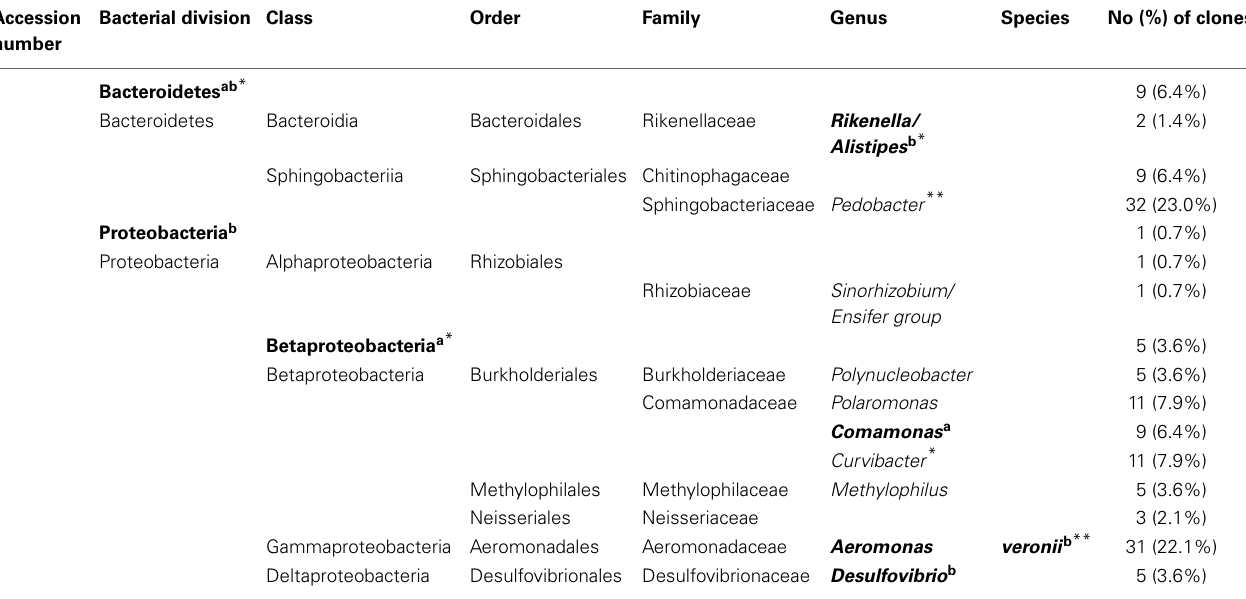
Table 1 | 16S rRNA sequences obtained from adult medicinal leech, H. verbana , mucosal secretions. Accession Bacterial division number